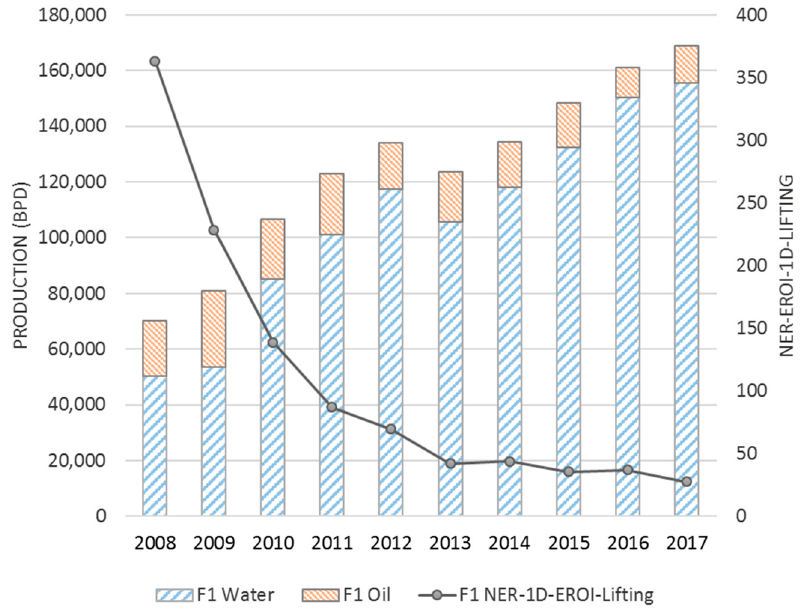
Figure 1. Field 1 Production vs. NER-1d-EROI Lifting.